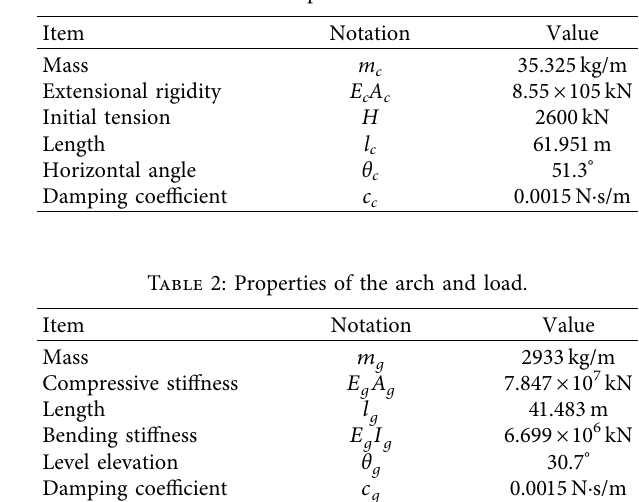
Table 1: Properties of the cable.